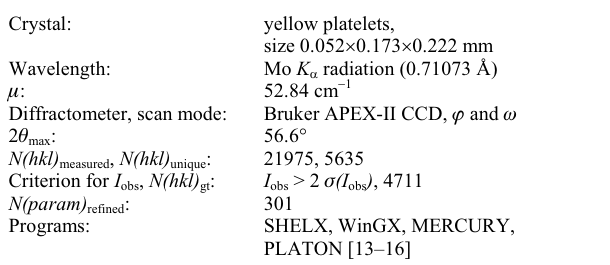
Table 1. Data collection and